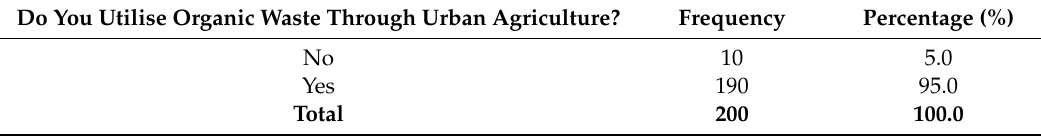
Table 3. The proportion of respondents who utilise organic waste through urban agriculture in the Durban South Basin (n =